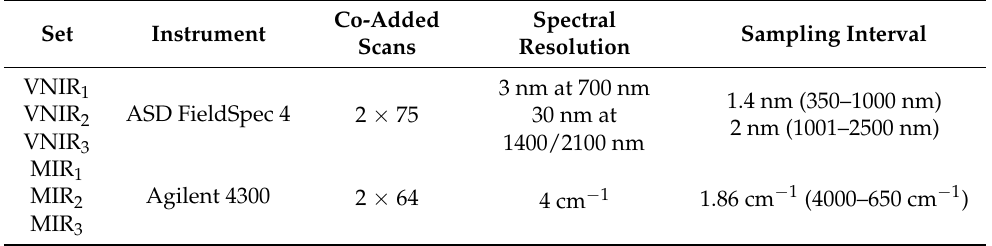
Table 1. Measurement and instrument parameters for collected VNIR and MIR